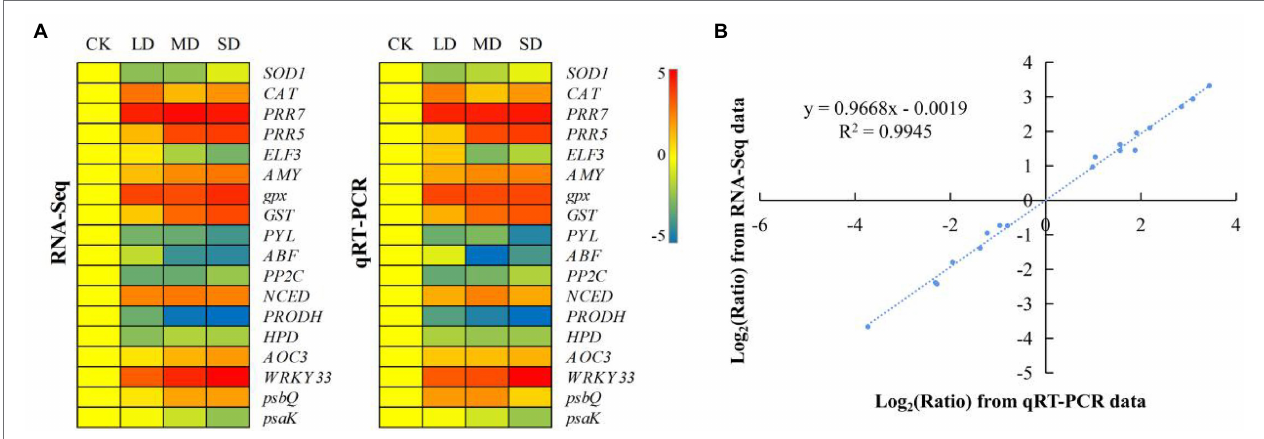
FIGURE 5 | Expression patterns of 18 selected genes identified by RNA-seq were verified via quantitative real-time (qRT) PCR. (A) Heatmap showing the expression changes [log 2 (fold-change [FC])] in response to the CK to SD treatments for each candidate gene, as measured by RNA sequencing (RNA-seq) and qRT–PCR. (B) Scatter plot showing the changes in the expression [log 2 (FC)] of selected genes based on RNA-seq via qRT–PCR. The gene expression levels are indicated by coloured